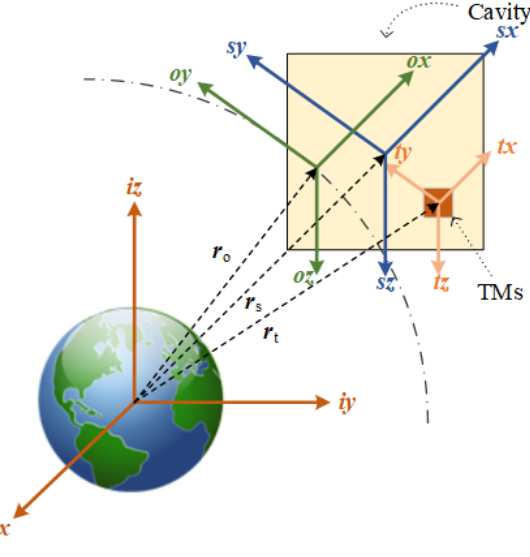
Figure 1. Reference